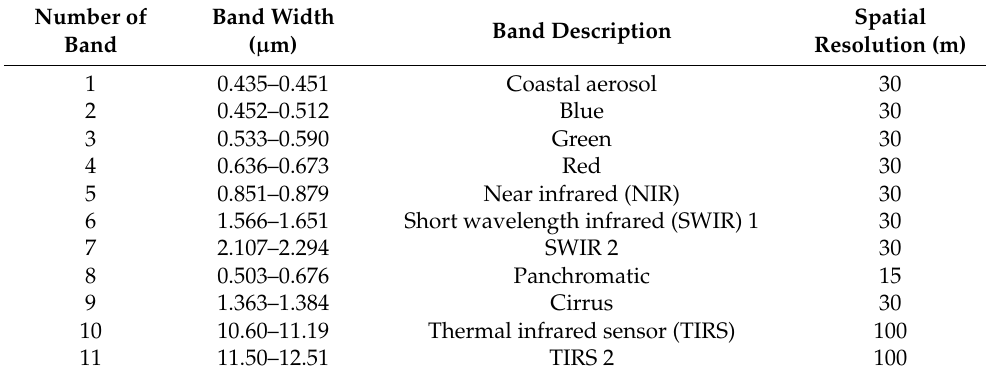
Table 1. Bandwidth and spatial resolution of the Landsat 8 OLI/TIRS.